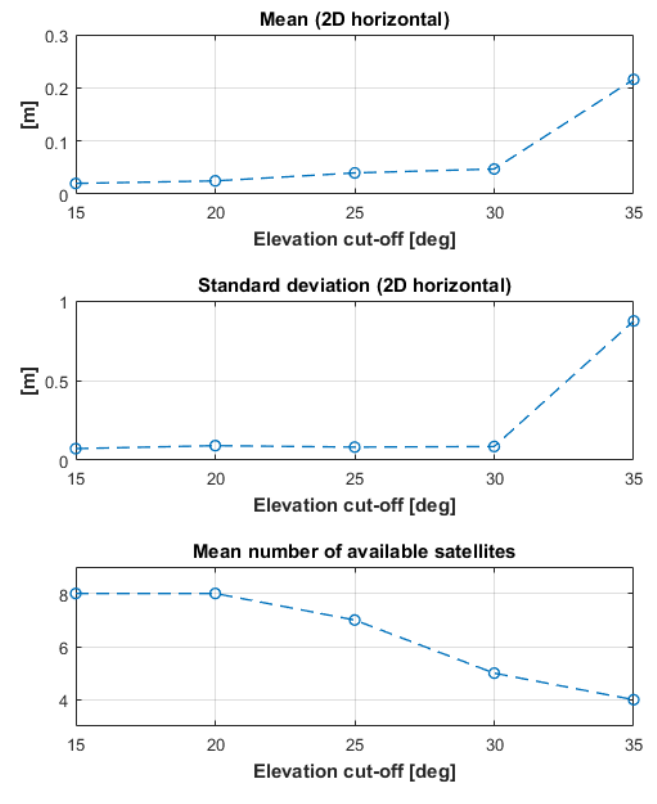
Figure 7. Solution degradation as the elevation cut-off angle is increased from 15 to 35